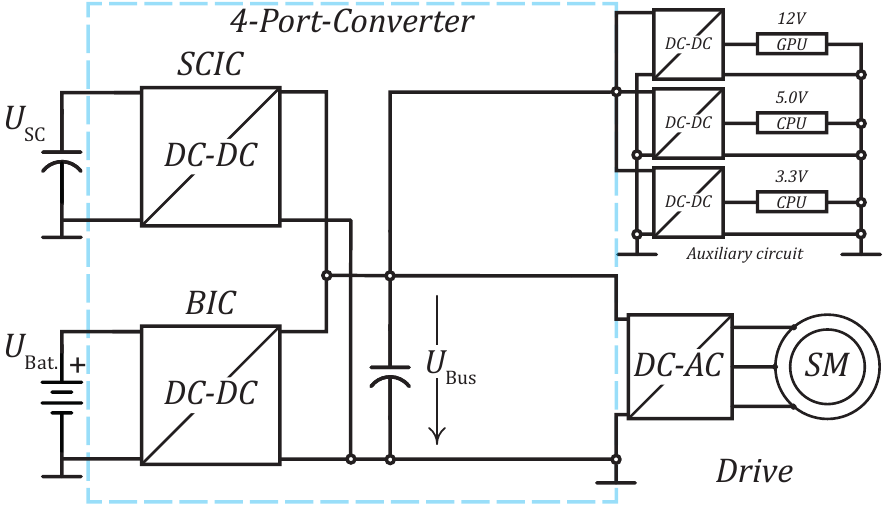
Figure 10. Topology VI: Extension of the standard solution with a super-capacitor module and an interface